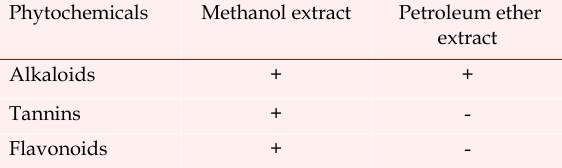
Phytochemical investigation of R. scabra Phytochemicals